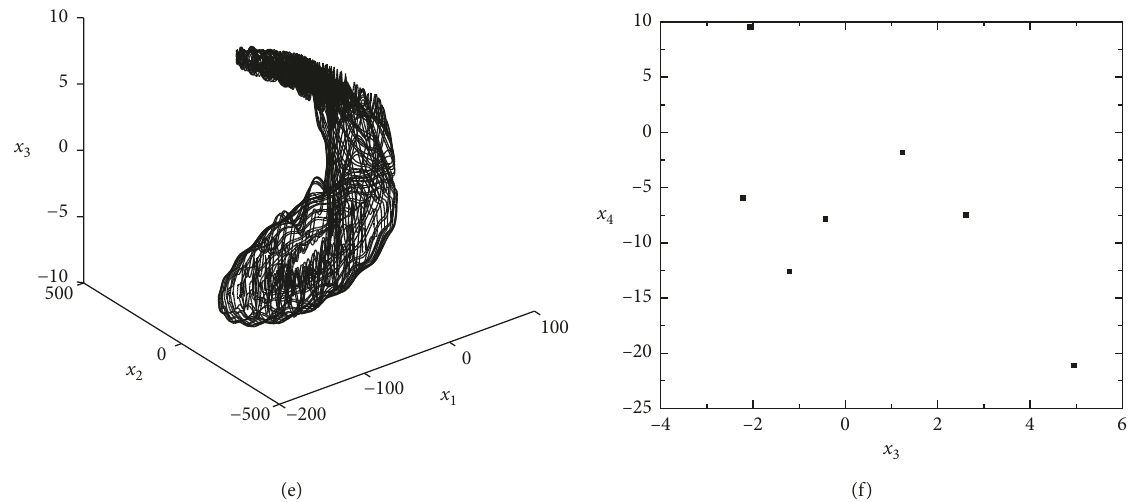
Figure 15: Chaotic motion of the composite shell when f increases to 270. (a) Waveform in the plane ( t, x ) . (c) Two-dimensional phase portrait in the plane ( x ( t, x 3 dimensional phase portrait in the plane ( x